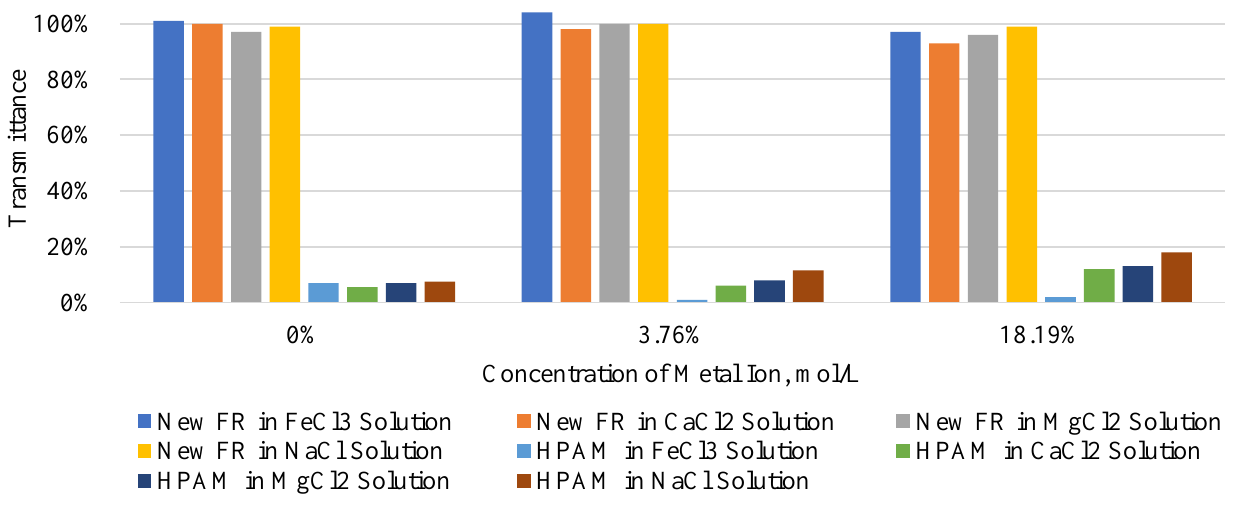
Figure 14—Transmittance results of the less-damaging FR vs. HPAM.